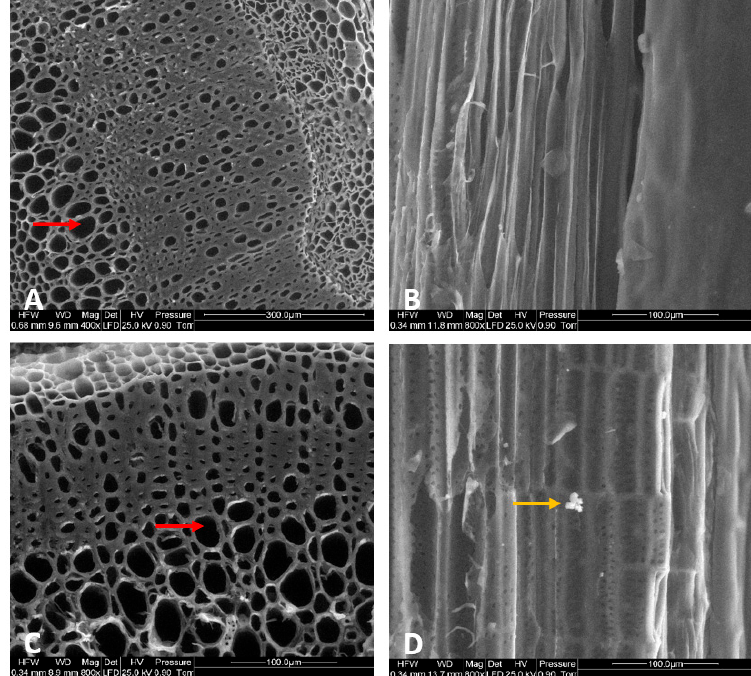
Figure 3. Cross section ( A , C ) and longitudinal section ( B , D ) through the stem of peony ‘Sarah Bernhardt’: A , B —immediately after harvest; C , D —after 12 weeks of storage. vascular bundles free of bacteria proliferation; callose.